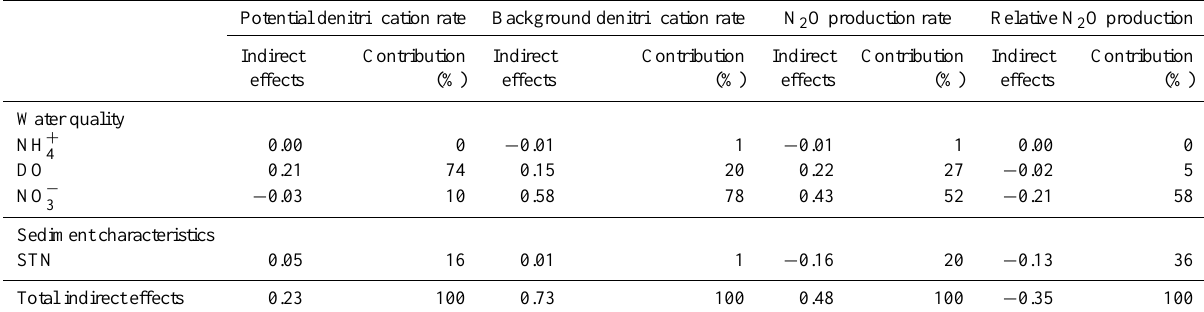
Table 4. Indirect effects of human-dominated land uses on sediment denitrification in lakes mediated by lake water quality and sediment characteristics ( N = 20).